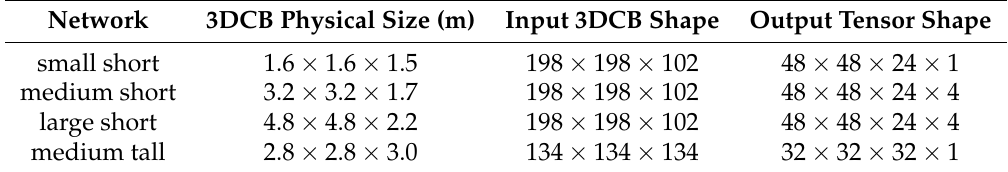
Figure 16. Segmentation architecture (used for large short scale). Every 3D CNN layer will be followed by a dropout layer. The tensor shape shown here is the output shape of each block. It provides the (width, depth, height, channel) information of the network. The other three scale networks have the same structure with different input size as shown in Table 2. Table 9. Input and output shapes for the segmentation network based on different scale networks. We combine the table and desk into the same category, so we have the number of categories for the medium short is 4 instead of